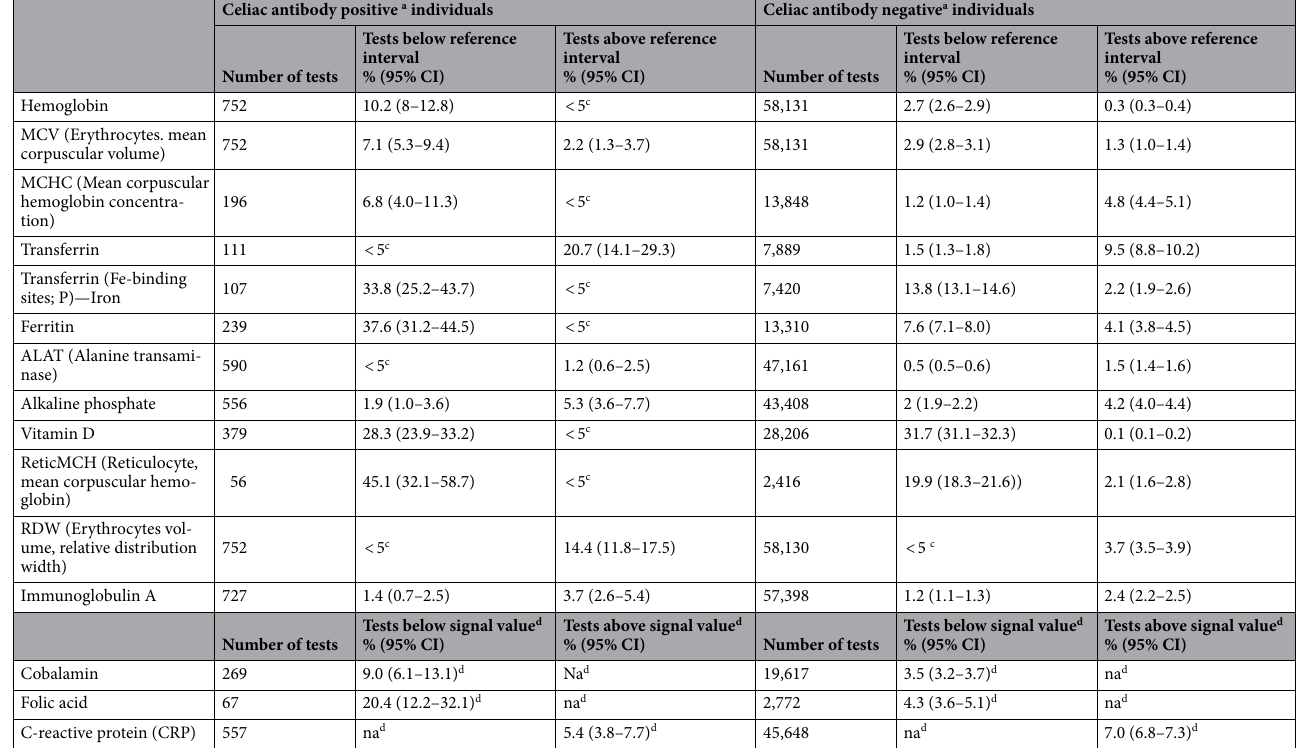
Table 4. Results of hematological and biochemical biomarker measurements during the period six months prior to one month after celiac disease antibody measurement among individuals with positive and negative celiac antibody tests a . Test results are defined as below or above sex-specific reference intervals for each measurement of the biomarker b . b See Additional Table S2 (Additional file 1) for reference intervals or signal values. a A positive celiac antibody test was defined as: IgA/IgG TTG of at least 7 U/ml or IgG DGP of at least 10 U/ml and a negative test was defined as IgA /IgG TTG under 7 U/ml and IgG DGP under 10 U/ml. c Results where the total number of observations was under 5 are not shown due to anonymization. d For Cobalamin, Folic acid and CRP the results are listed with signal values and not reference interval. Therefore, results below the signal value for folic acid and cobalamin are considered as abnormal and for CRP results above the signal value are considered as abnormal. CI Confidence interval; NA not